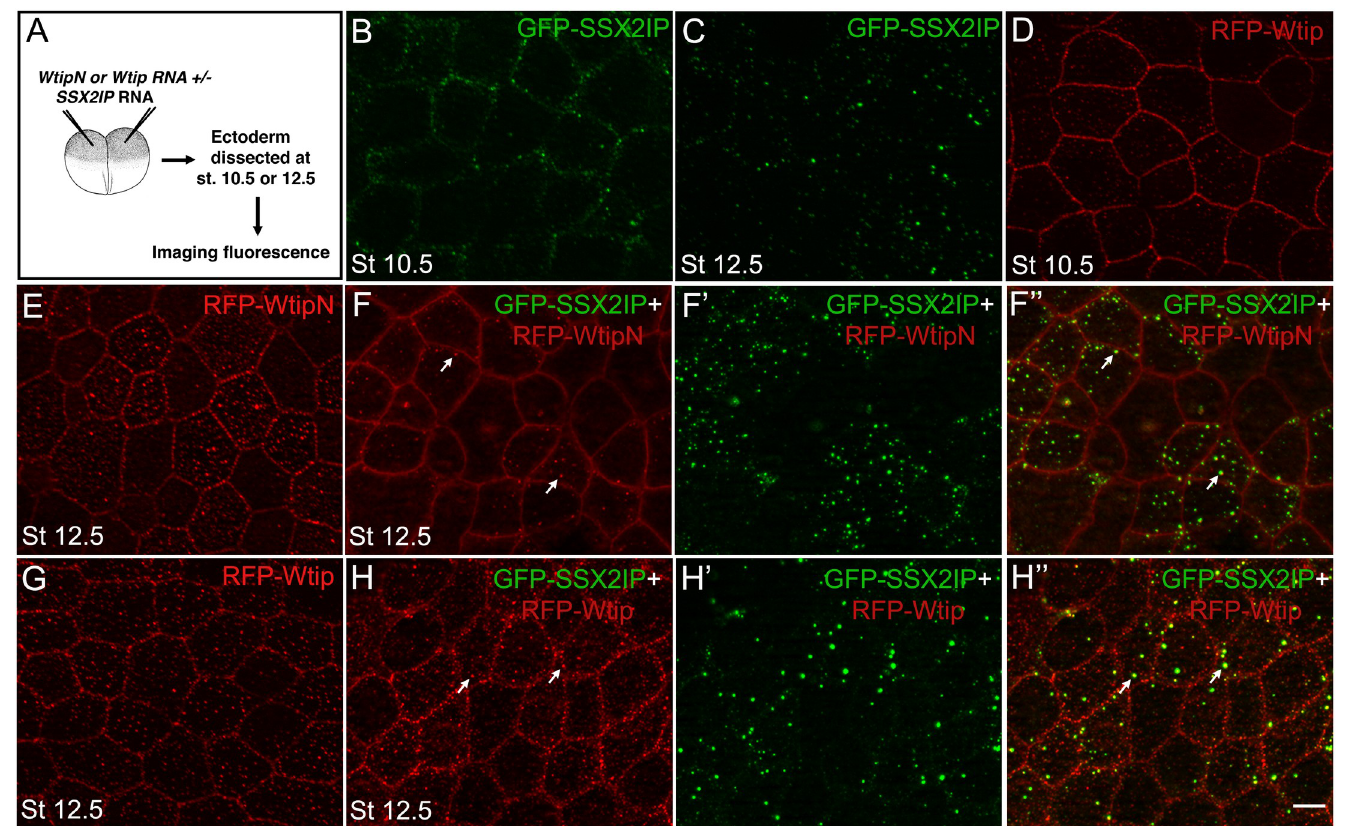
Fig 5. SSX2IP and WtipN co-aggregate in ectoderm cells. A, Experimental scheme. HA-RFP-Wtip or HA-RFP-WtipN RNA (50 pg each) was coinjected with GFP-SSX2IP RNA (50 pg) into four-cell embryos. When the embryos reached stage 10 or 12.5, ectoderm was dissected, fixed, and fluorescent protein localization at the cortex and cytoplasmic puncta was imaged at indicated stages. B, GFP-SSX2IP, stage 10.5. C, GFP-SSX2IP, stage 12.5. D, HA-RFP-Wtip, stage 10.5. E, HA-RFP-WtipN, stage 12.5. F-F”, Mixed cytoplasmic aggregates (arrows) in cells coexpressing GFP-SSX2IP and RFP-WtipN, stage 12.5. F, red channel, F’ green channel, F”, merged image. G, HA-RFP-Wtip, stage 12.5. H-H”, Partial colocalization of GFP-SSX2IP and HA-RFP-Wtip in cytoplasmic puncta (arrows). Scale bar, 15 μ m. Images are representative of 3 independent experiments, with 10–15 embryos imaged per group in each experiment.